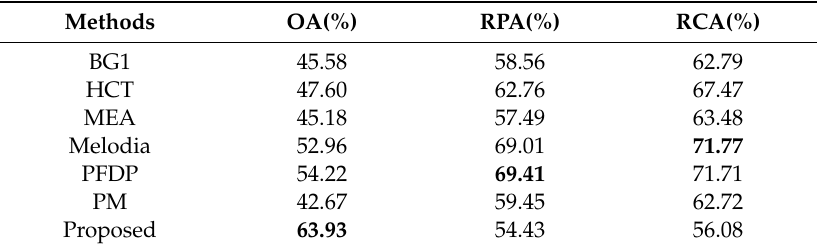
Table 5. Averaged accuracies on three